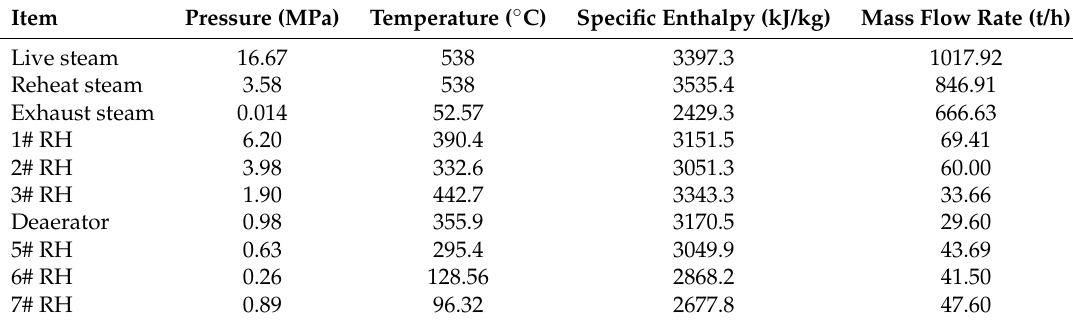
Table 2. Steam parameters of the power plant in turbine maximum continuous rating (TMCR) conditions.